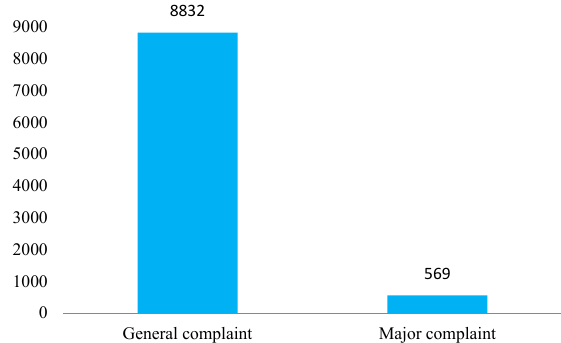
Figure 3. Number of cases with different complaint grades.